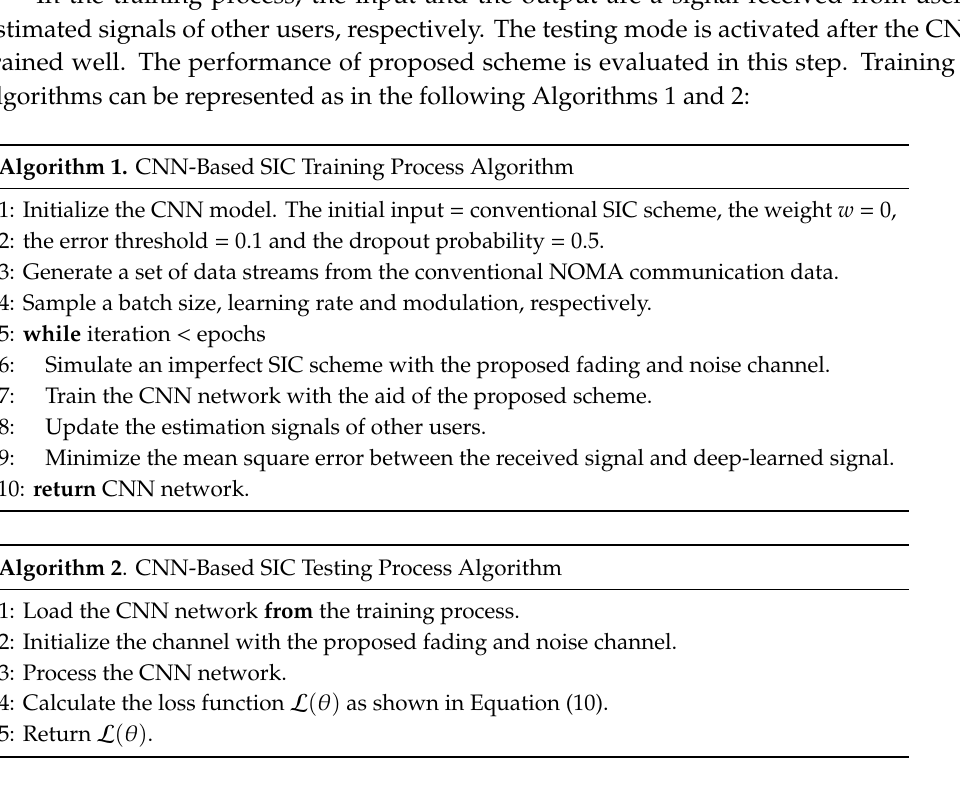
Algorithm 1. CNN-Based SIC Training Process Algorithm